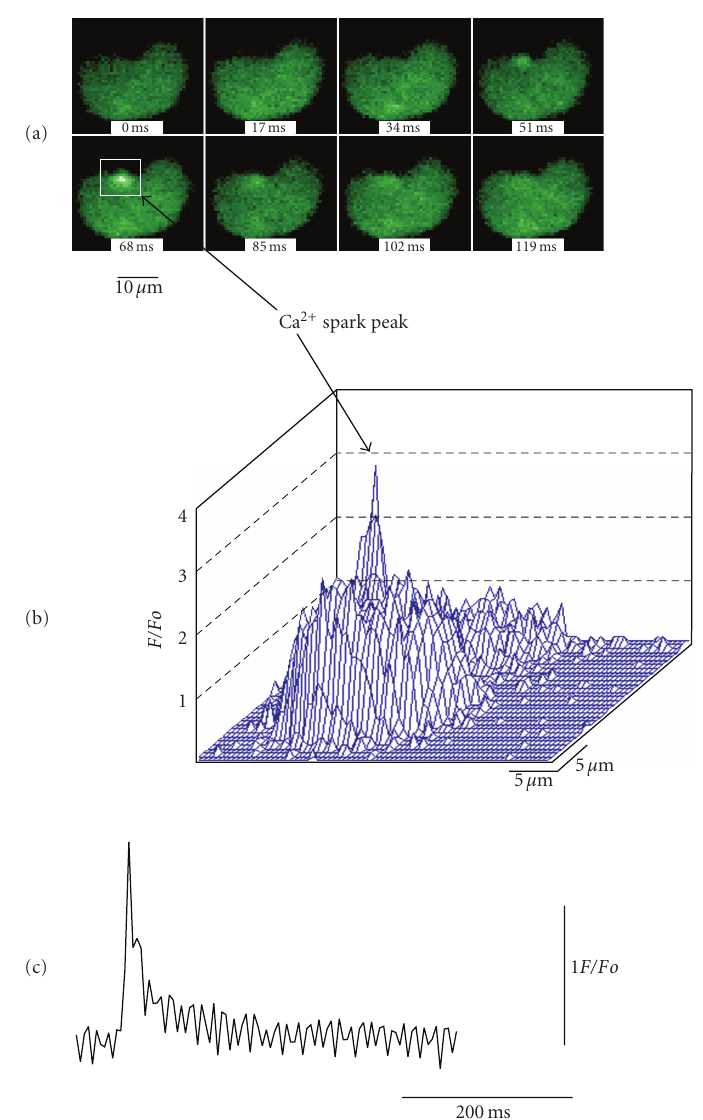
Figure 1: Calcium spark in a rat tibial artery smooth muscle cell . (a) Series of 8 consecutive laser scanning confocal images (17 milliseconds apart) illustrating a calcium spark. The calcium spark area is marked by a square and the peak of the calcium spark is indicated by arrows (b). The myocyte was loaded with the Ca 2+ indicator dye fluo-3. Two-dimensional (2D) images were obtained using a Nipkow spinning disk confocal microscope (Perkin Elmer, UltraView LCI). (b) Three-dimensional plot of fluorescence intensity of the cell shown in (a) at 68 milliseconds. The calcium spark occurred in close proximity to the plasma membrane. (c) Time course of the calcium spark in the marked area. The amplitude is expressed as F/Fo . F is the fluorescence intensity in the marked area where the spark appeared. Fo is fluorescence intensity of the same cell area in the absence of calcium